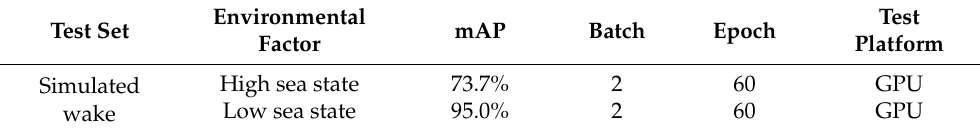
Figure 14. P-R Curve of a simulated SAR Image as test set: ( a ) P-R curves in different sea states (Low sea state: red line; High sea state: blue dot line); ( b ) P-R curves under different network structures. Table 3. Training results of test sets consisting of simulated ship wakes in different sea states.